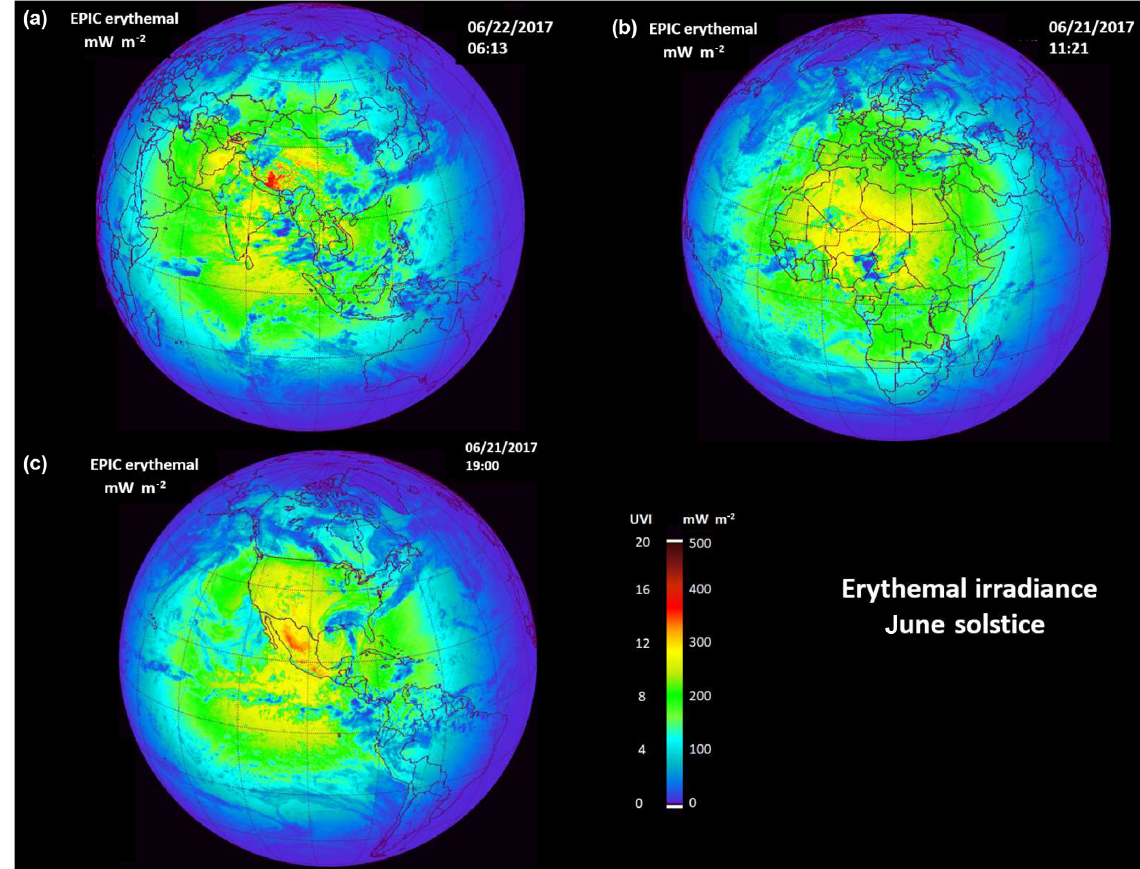
Figure 10. Erythemal irradiance E(ζ,ϕ,z,t) and UVI( ζ,ϕ,z,t ) from sunrise to sunset for the 21 June 2017 solstice. The three images are for different GMT. (a) 22 June 2017 (06:13GMT). (b) 21 June 2017 (11:21GMT) and (c) 21 June 2017 (19:00GMT). The images correspond to the sub-solar points over different continents caused by the Earth’s rotation (15 ◦ h − 1 ). Figure map created with IDL ®